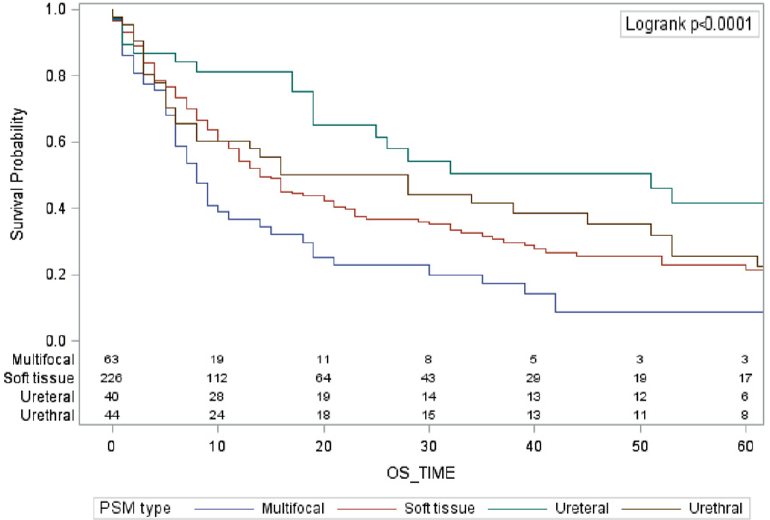
Figure 1. Kaplan–Meier curves reporting overall survival probability stratified by the type of PSMs.